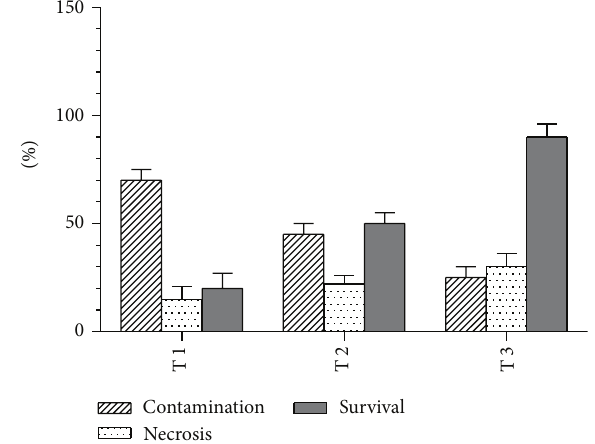
Figure 2: Percentage of surviving explants under different treat- ments in surface